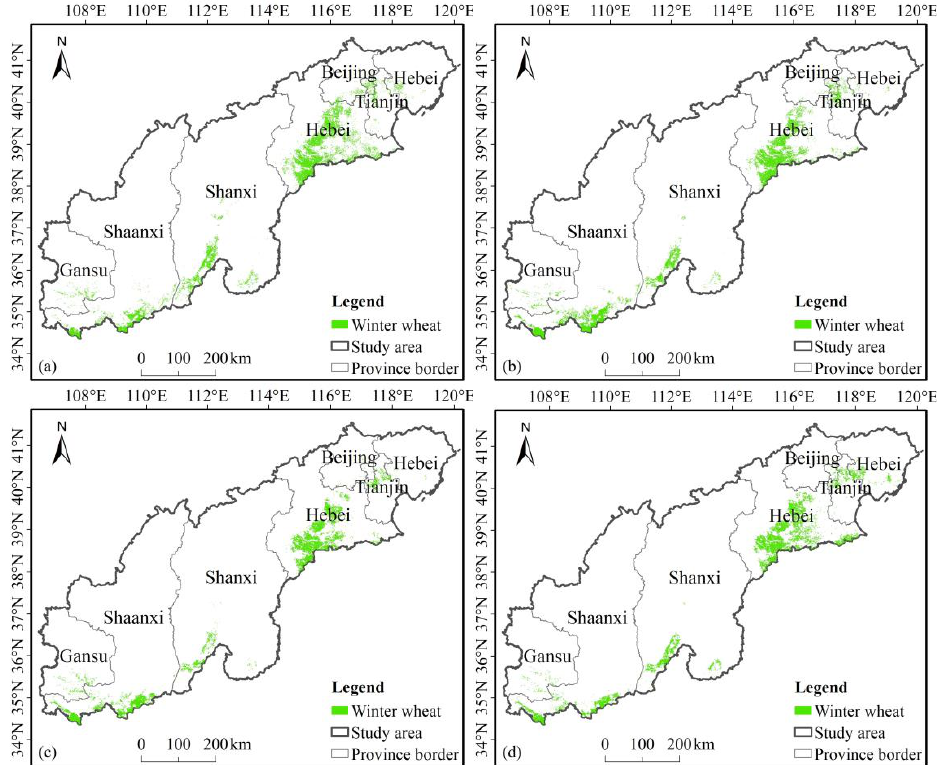
Figure 6. Spatial distribution of winter wheat planting area based on MODIS in 2001( a ), 2007( b ), 2014( c ) and 2019( d ).